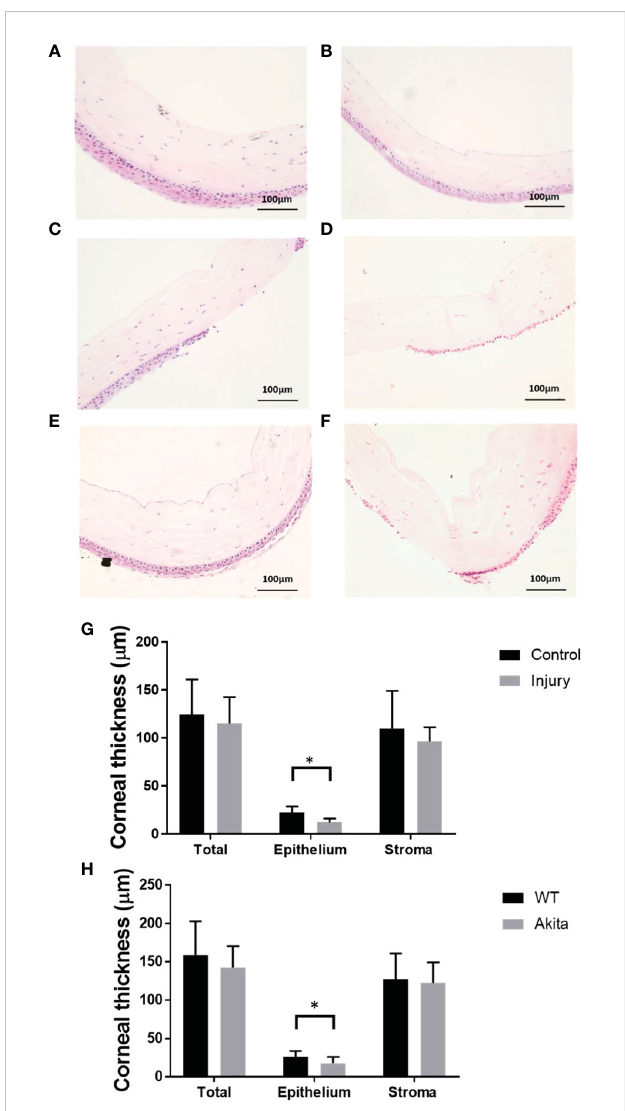
FIGURE 4 H&E staining of the cornea cross section and thickness measurements. Representative images of corneas were selected from (A) a WT mouse at baseline, (B) an Akita mouse at baseline, (C) a WT mouse immediately after corneal alkaline injury, (D) an Akita mouse immediately after corneal alkaline injury, (E) a WT mouse immediately at day 3 after corneal alkaline injury, and (F) an Akita mouse immediately at day 3 after corneal alkaline injury. (G) Corneal thickness measurement for total cornea, corneal epithelium, and corneal stroma for mouse corneas without injury (control group) and those immediately after injury; signi fi cantly reduced cornea thicknesses were found in the injured group compared with controls ( n = 7, p = 0.0129). (H) Corneal thickness measurement for total cornea, corneal epithelium, and corneal stroma for corneas from WT mice and Akita mice at day 3 after injury. Signi fi cantly reduced cornea thickness was found for Akita mice at day 3 after injury compared to the WT group ( n = 7 for both the WT and Akita groups, p = 0.0498).